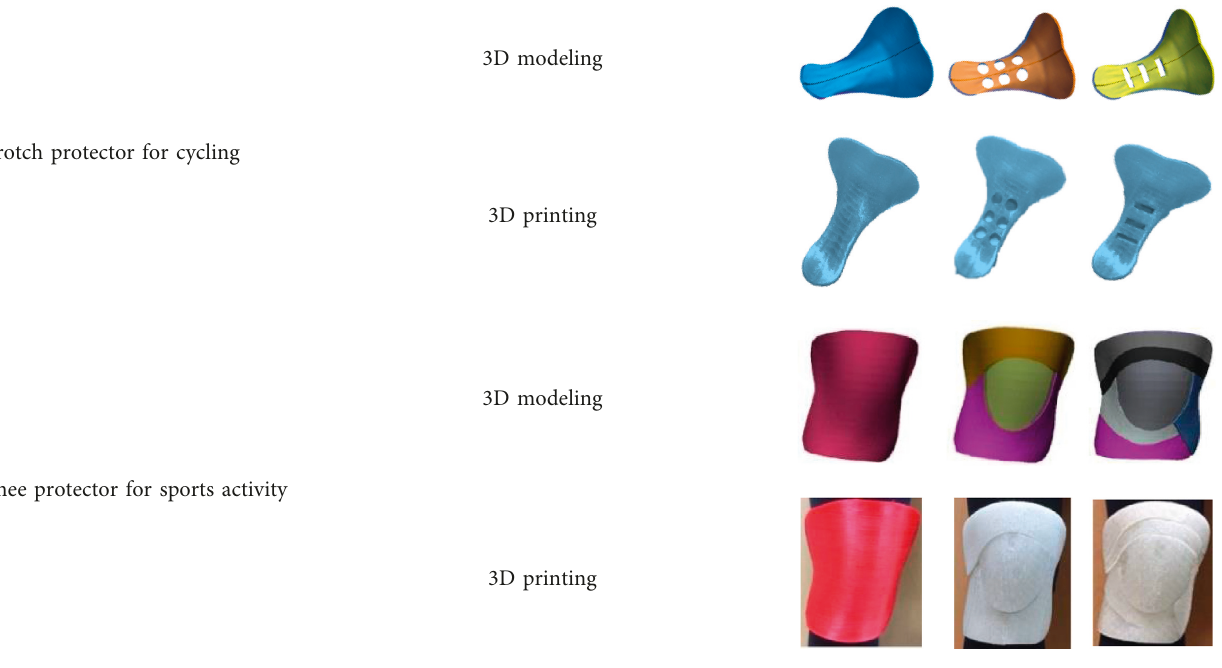
Crotch protector for